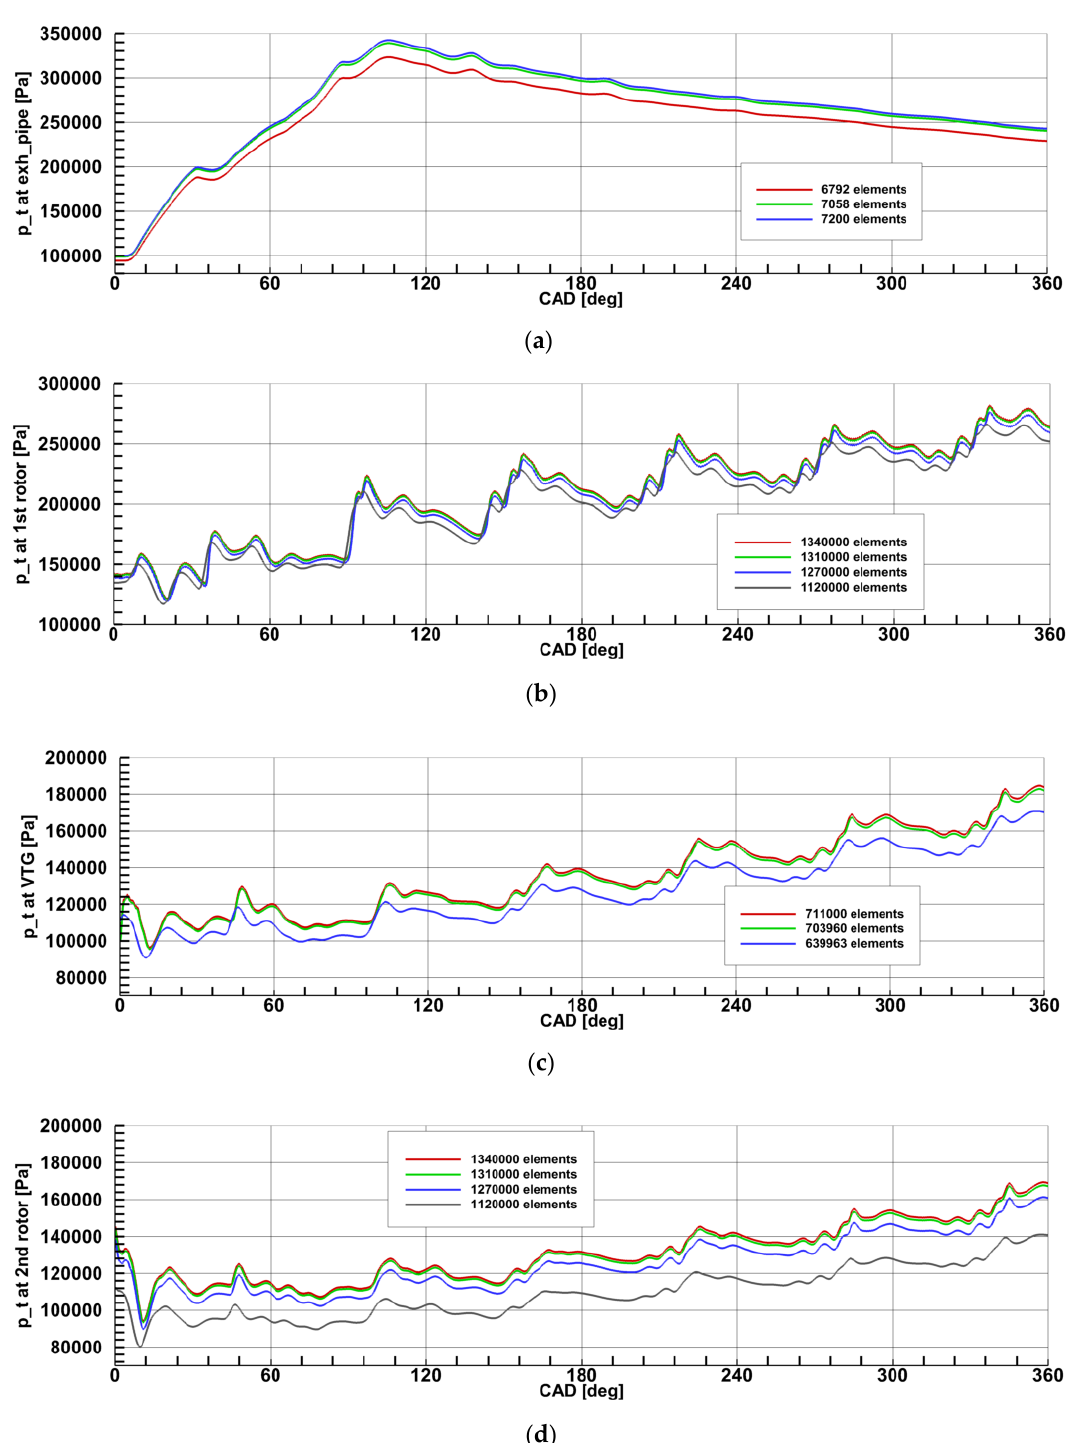
Figure 4. The total pressure plot against different number of elements during the single revolution of the crankshaft for the: ( a ) exhaust pipe, ( b ) first-stage rotor, ( c ) second-stage nozzle vanes, ( d ) second-stage rotor.